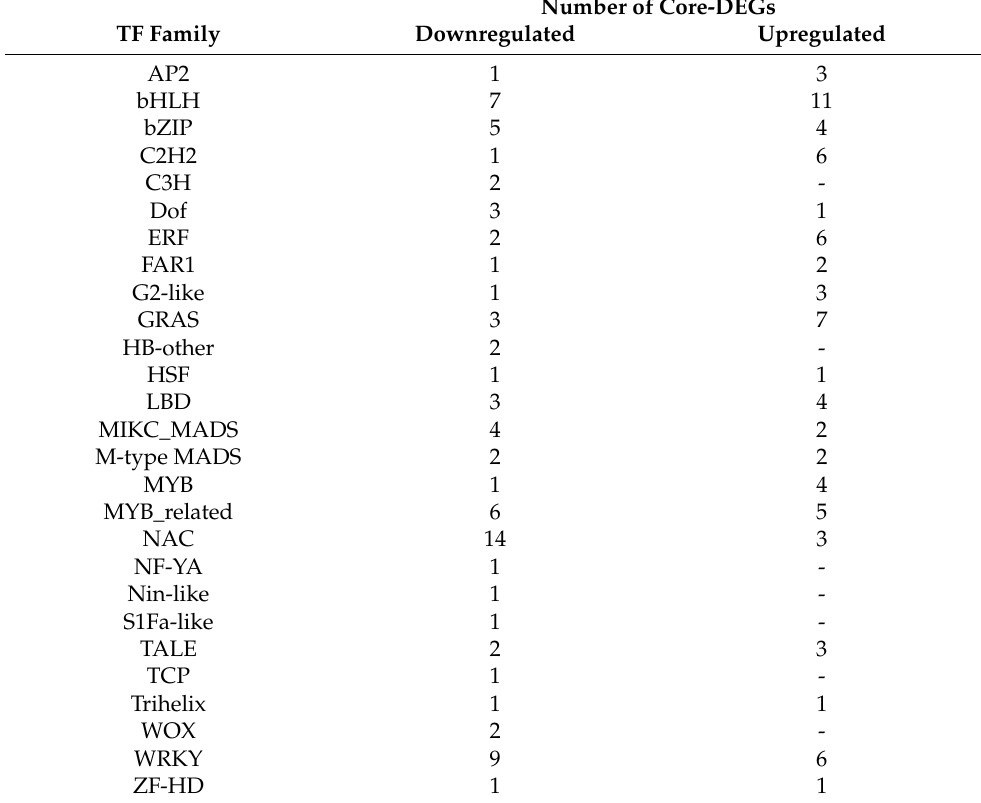
Table 2. Genes coding for transcription factors identified among the